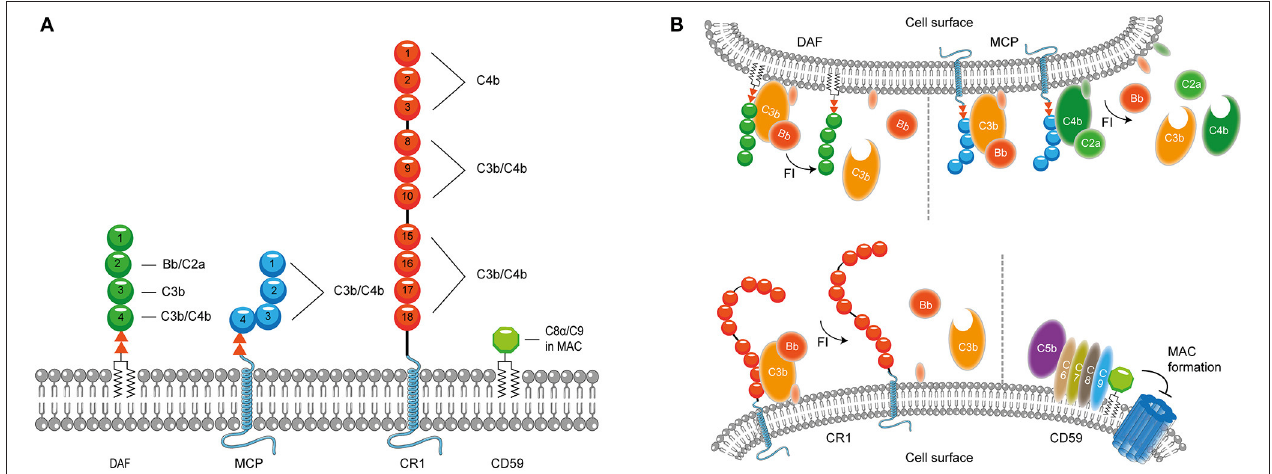
FIGURE 1 | Membrane bound complement regulatory proteins. (A) Membrane bound complement regulatory receptors DAF, MCP, CR1, and CD59. The SCRs important for the binding of complement targets are indicated. (B) DAF, depicted in the upper membrane, accelerates the decay of C3 convertases and prevents formation of new C3 convertases. MCP, depicted next to DAF, acts as a cofactor for FI, which cleaves C3b and C4b. On the lower membrane, CR1 is shown which acts as a cofactor for FI mediating cleavage of C3b as well as C4b (not depicted in this picture). Lastly, CD59 binds to C5b-8 and C5b-9 preventing the formation of the MAC. Figure was produced using Servier Medical